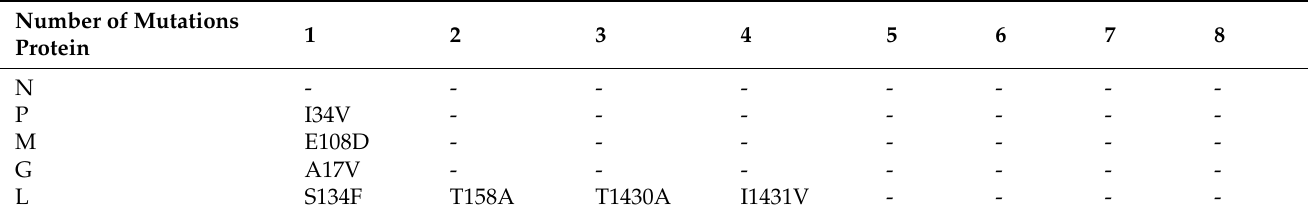
Table 1. Overview of amino acid substitutions present only in strain V viruses, but not in other BoDV-1.